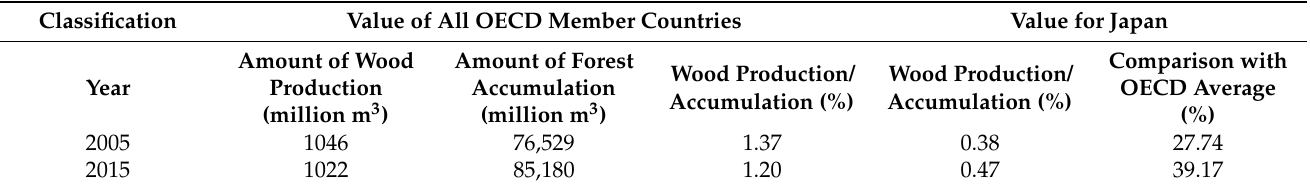
Figure 2. Ratio of timber to forest production of some OECD countries, based on [50]. Table 3. Timber to forest production ratio, based on